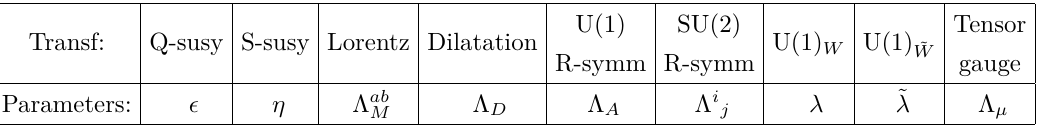
Table 2 . Superconformal symmetries and their transformation